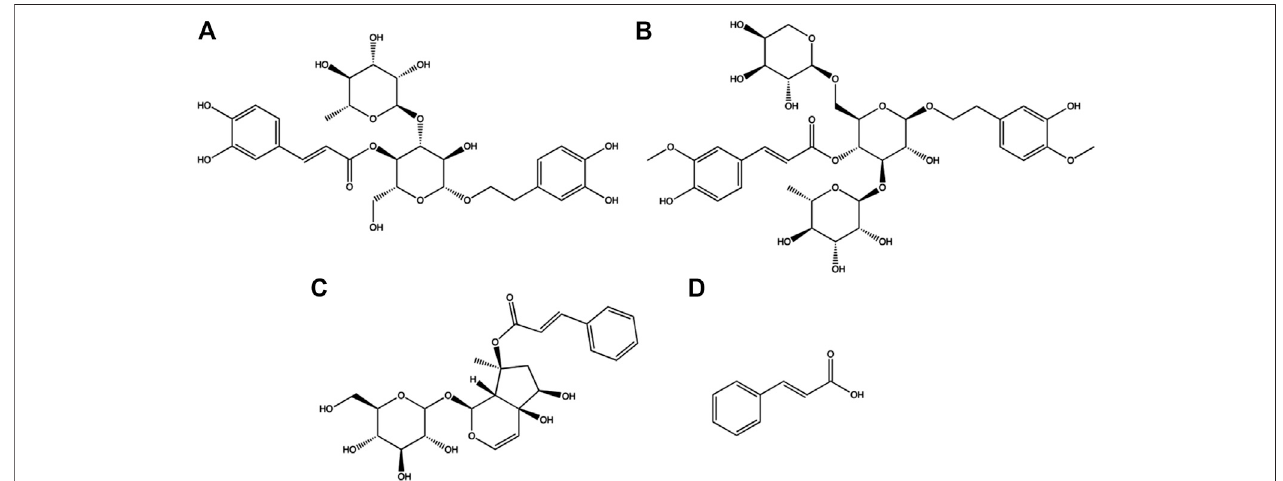
FIGURE 1 | Chemical structures of acteoside (A) , angoroside C (B) , harpagoside (C) and cinnamic acid (D) in this study.